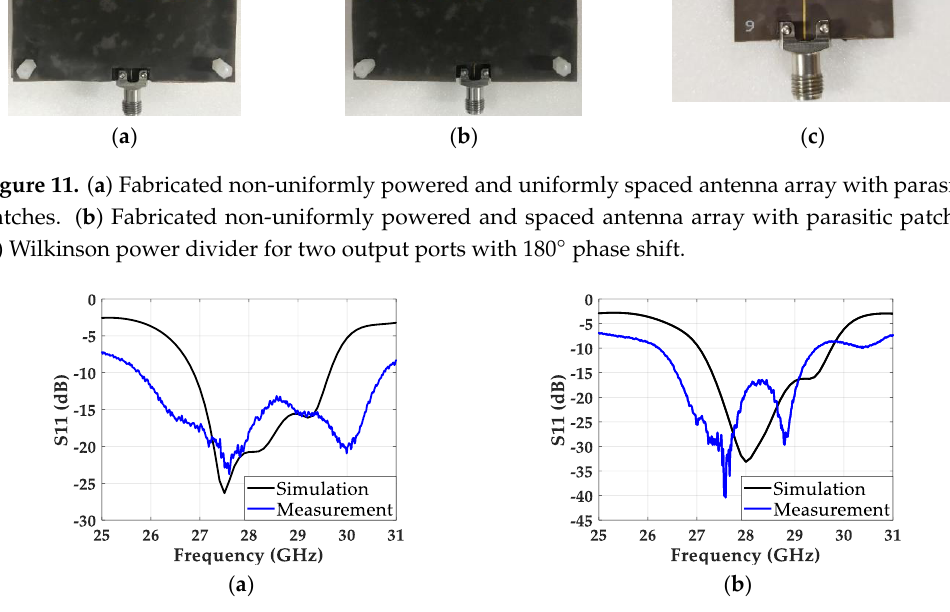
Figure 12. Simulation and measured S 11 of ( a ) the non-uniformly powered and uniformly spaced antenna array, and ( b ) the non-uniformly powered and spaced antenna array.